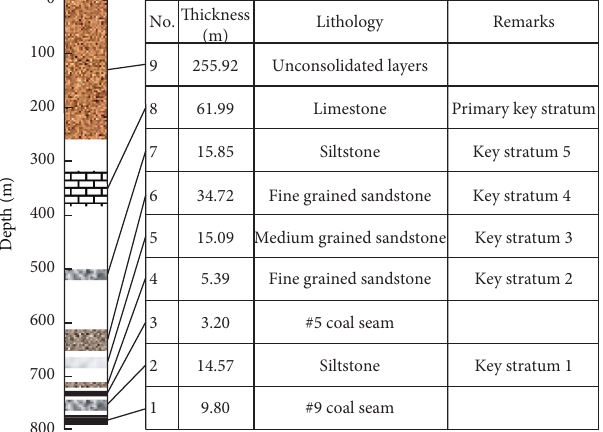
Figure 2: Identification results of key strata in J-9